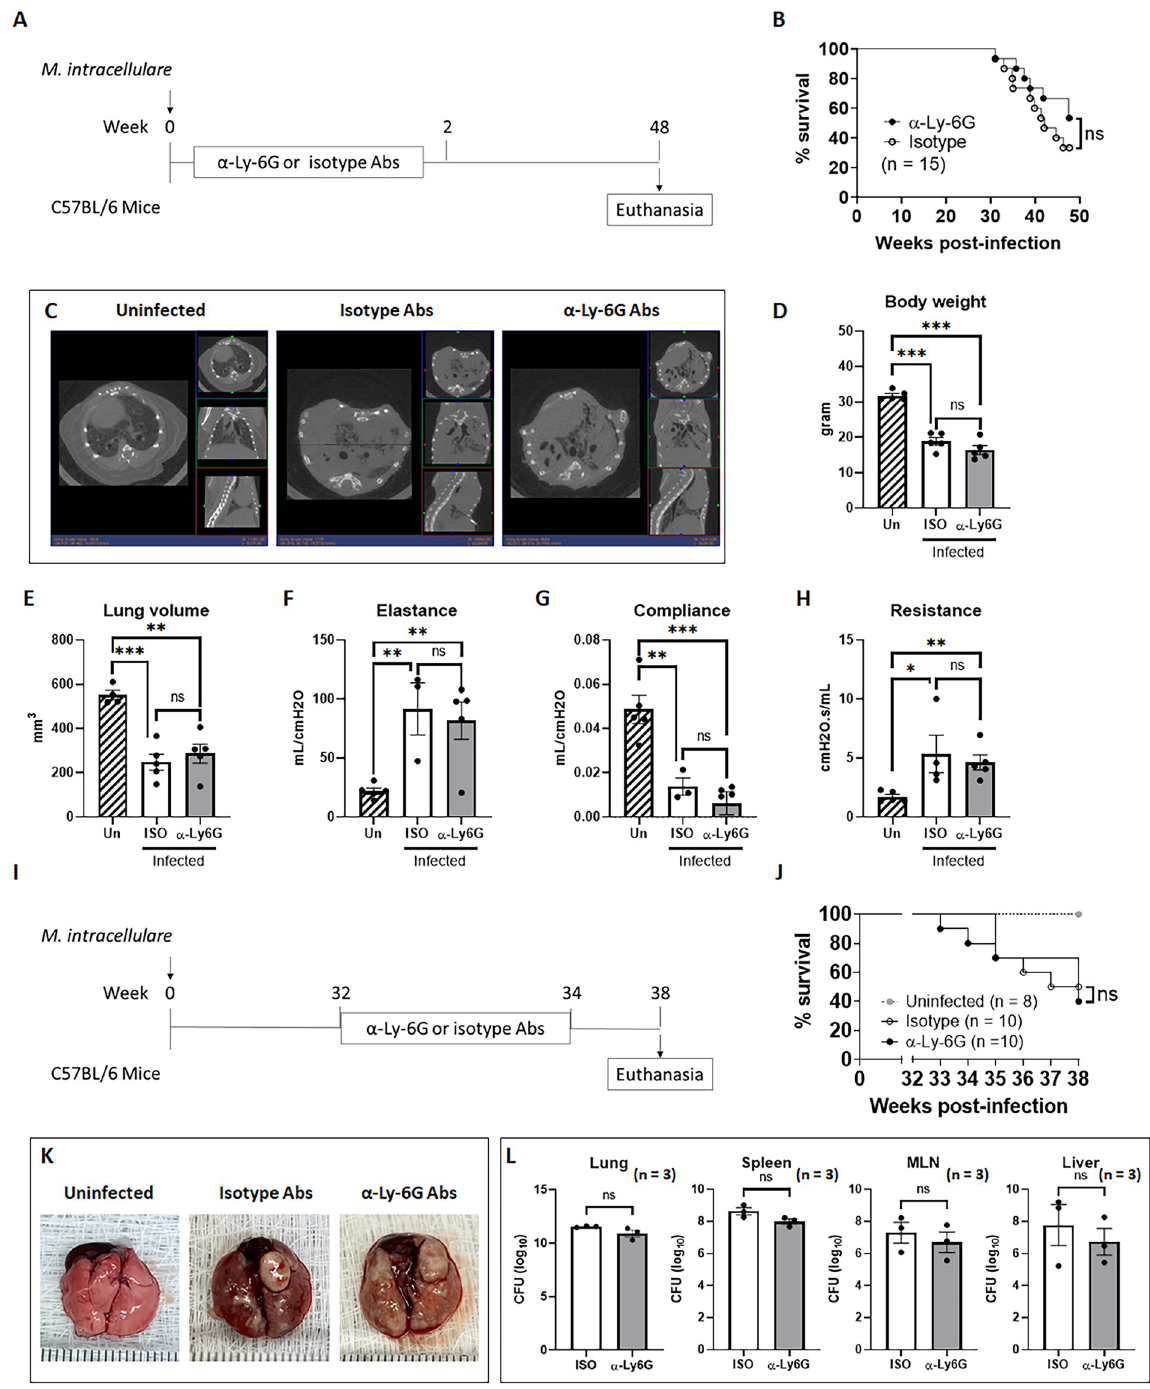
Fig 5. Anti-Ly6G mAb treatment during early and chronic infection has no effect on mortality or lung damage in chronically infected mice. ( A ) Schematic representation of M . intracellulare infection and the experimental schedule for early neutrophil depletion are shown. C57BL/6 mice were infected with clinical isolates of M . intracellulare (5 × 10 7 CFU) via the intranasal route. To deplete neutrophils, M . intracellulare -infected mice were intraperitoneally injected with anti-Ly6G mAb or rat IgG2a isotype control Ab every other day from 1 to 11 days postinfection. ( B) Survival curves for M . intracellulare -infected mice treated with anti-Ly6G mAb (black circle) or isotype control Ab (white circle) (B). Data were pooled from two independent experiments (total n = 15 mice per group). Survival curves were compared using the log rank test. ns, not significant. ( C-H ) Lung CT scanning and pulmonary function tests were conducted at 48 weeks postinfection. A representative lung CT scan image of each group is shown (C). Body weight (D), lung volume (E), lung elastance (F), lung compliance (G) and lung resistance (H) of